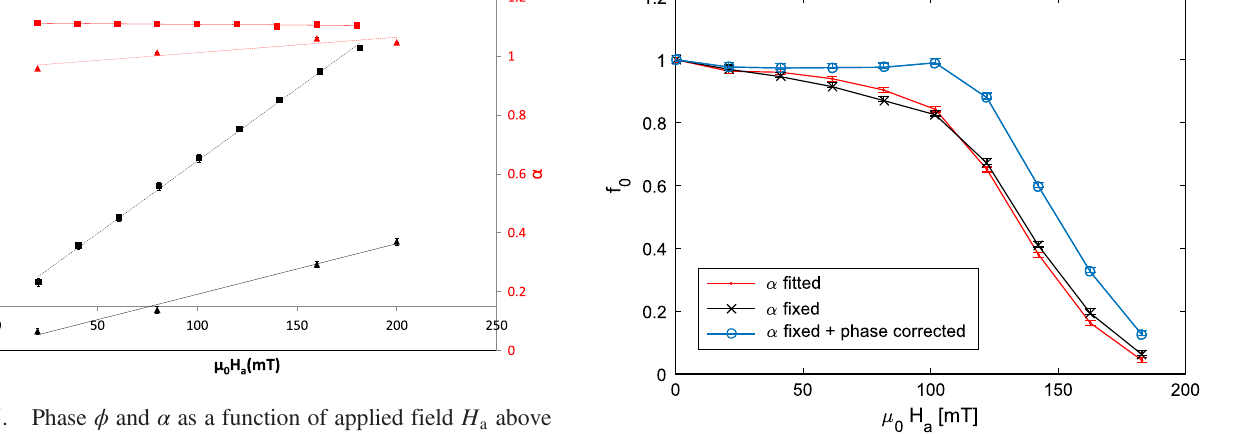
FIG. 5. Phase ϕ and α as a function of applied field H T . Triangles/Squares are for the HPF/LAMPF spectrometer. c